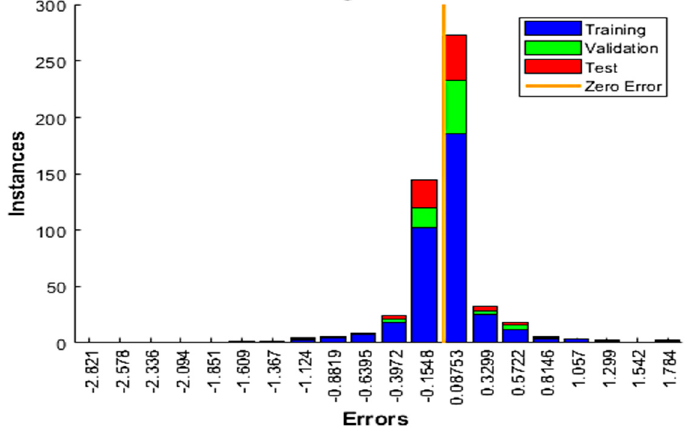
Figure 4. Error histogram of training data for the (5-15-10-1) Figure 4 . Error histogram of training data for the (5-15-10-1) network. Table 6. ANN-targeted weight left values using the new input datasets for the simulation step.